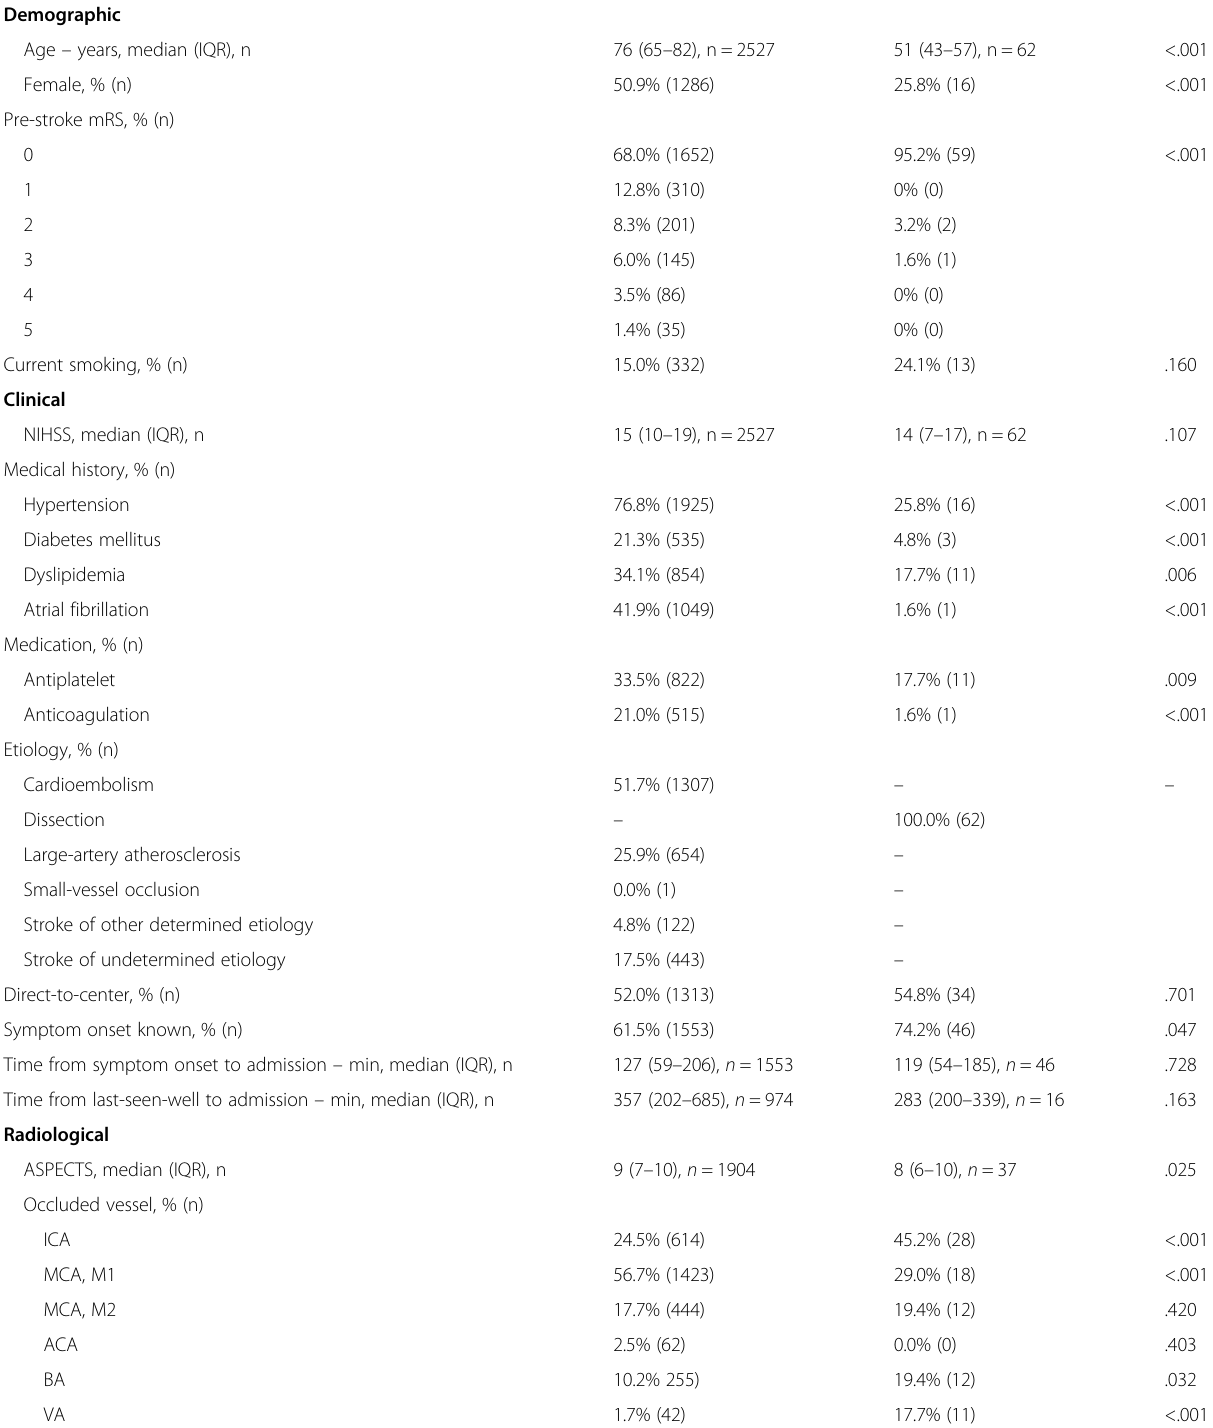
Table 1 Baseline